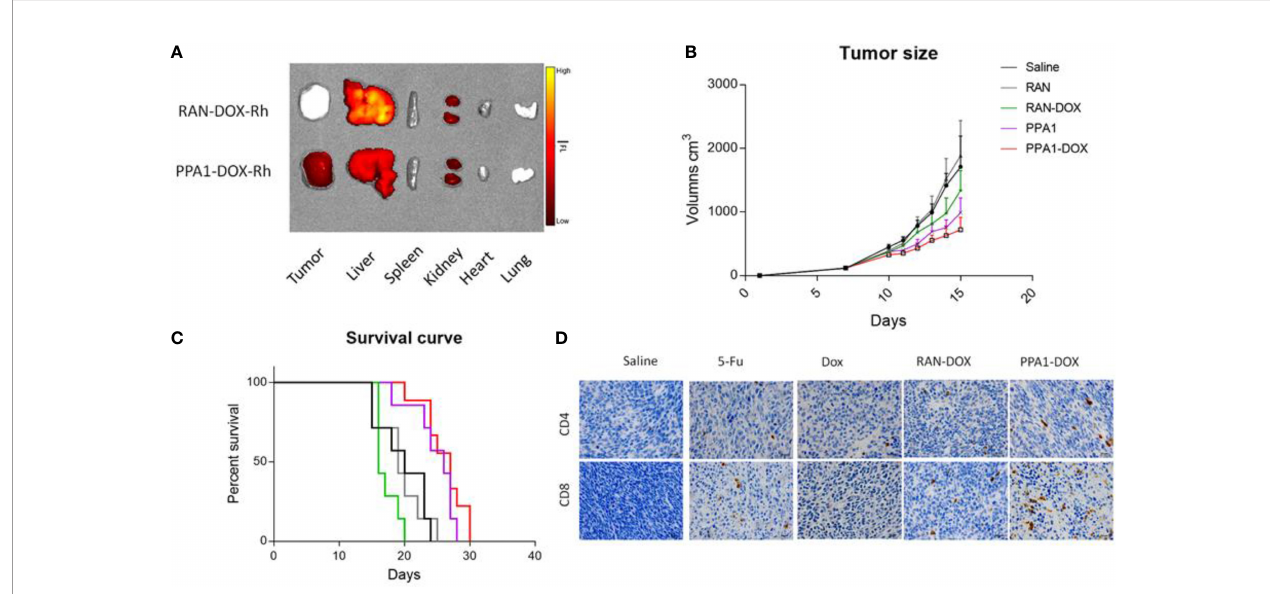
FIGURE 5 | The antitumor activity of PPA1-DOX in CT26-bearing mice. (A) The distribution of PPA1-DOX-RhB and RAN-DOX-RhB in tumor and major tissues at 24h post-intravenous injection. (B) Analysis of tumor sizes from 5 respective treatment group at a dosing frequency of twice a week via intraperitoneal injection. (C) The survival curve of 5 groups of treatment at a dosing frequency of twice a week via intraperitoneal injection. (D) CD4 and CD8 immunohistochemical staining of tumor tissues from the respective treatment group. Scale bars, 50 m m. The data were represented by means ± SEM. n = 7.